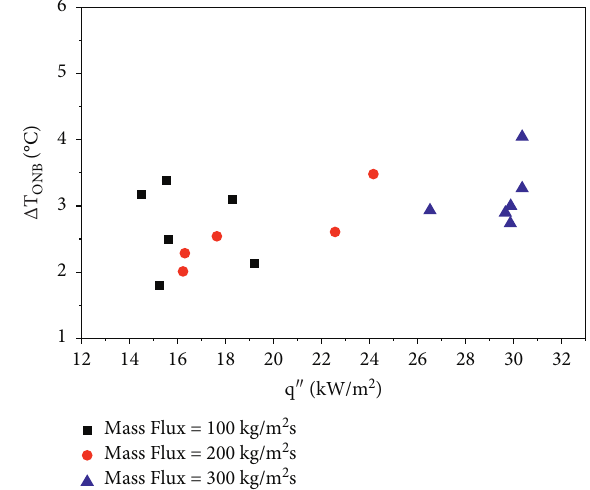
Figure 10: Effect of inlet temperature on Δ T 100kg/(m 2 · s)).